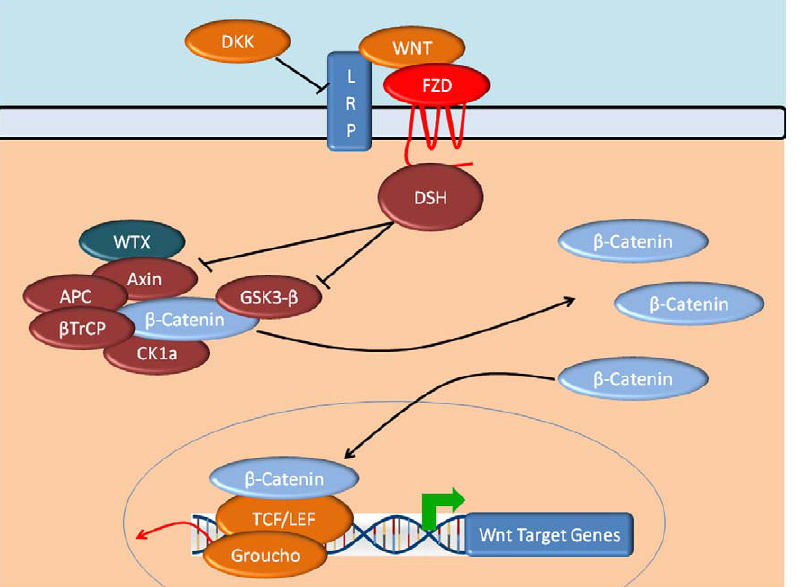
Figure 1. Schematic representation of the canonical Wnt signalling pathway. Gene names represented: Dishevelled ( DSH ), adenomatous polyposis coli ( APC ), low-density lipoprotein receptor related proteins ( LRP ), casein kinase 1 ( CK1a ), glycogen synthase kinase 3 ( GSK3- b ), b -transducin repeat-containing protein ( b -TrCP ), T-cell factor ( TCF )/lymphoid enhancer factor ( LEF ), Wilms tumor-suppressor ( WTX ), Frizzled ( FZD ), dickkopf homolog 1.